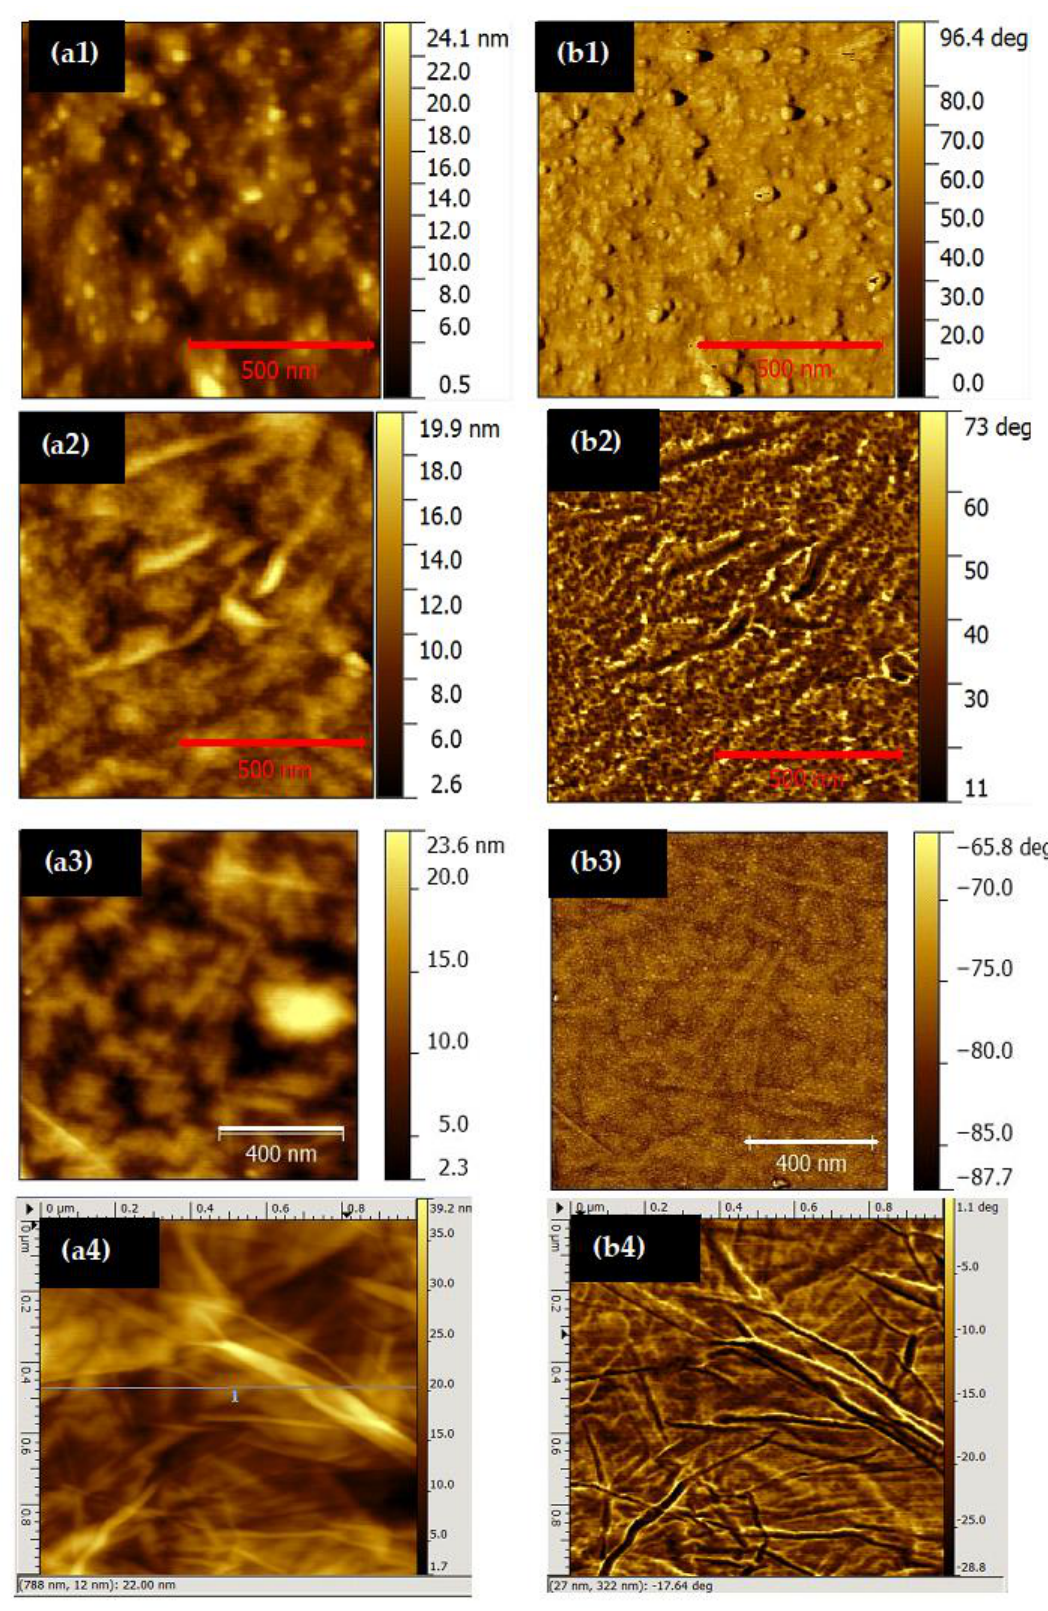
Figure 4. Topographic ( a ) and phase ( b ) images (1 × 1 μm 2 ) of: ( 1 ) PAH layer; ( 2 ) PAH/GO bilayer; ( 3 ) (PAH/GO) 2 LbL film; and ( 4 ) (PAH/GO) 20 LbL film.